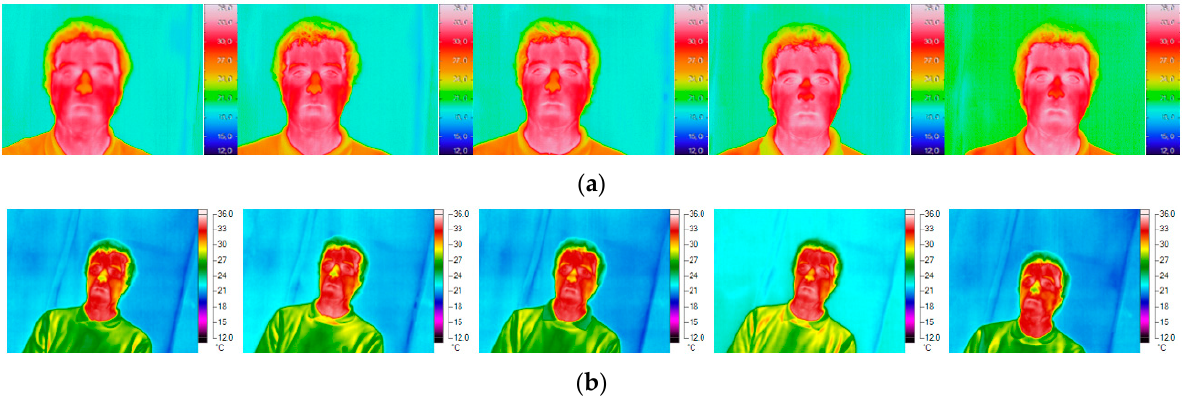
Figure 5. Thermal images for HR SP values of 40%, 50%, 60%, 70%, and 80% with a T SP of 20 °C: ( a ) IR camera 1; ( b ) IR camera 2.